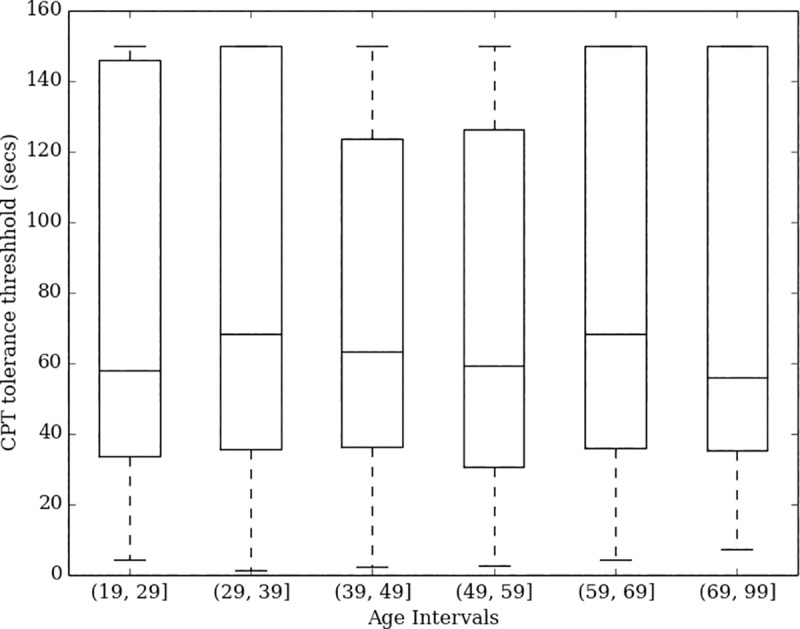
Box plot of CPT tolerance times by age.